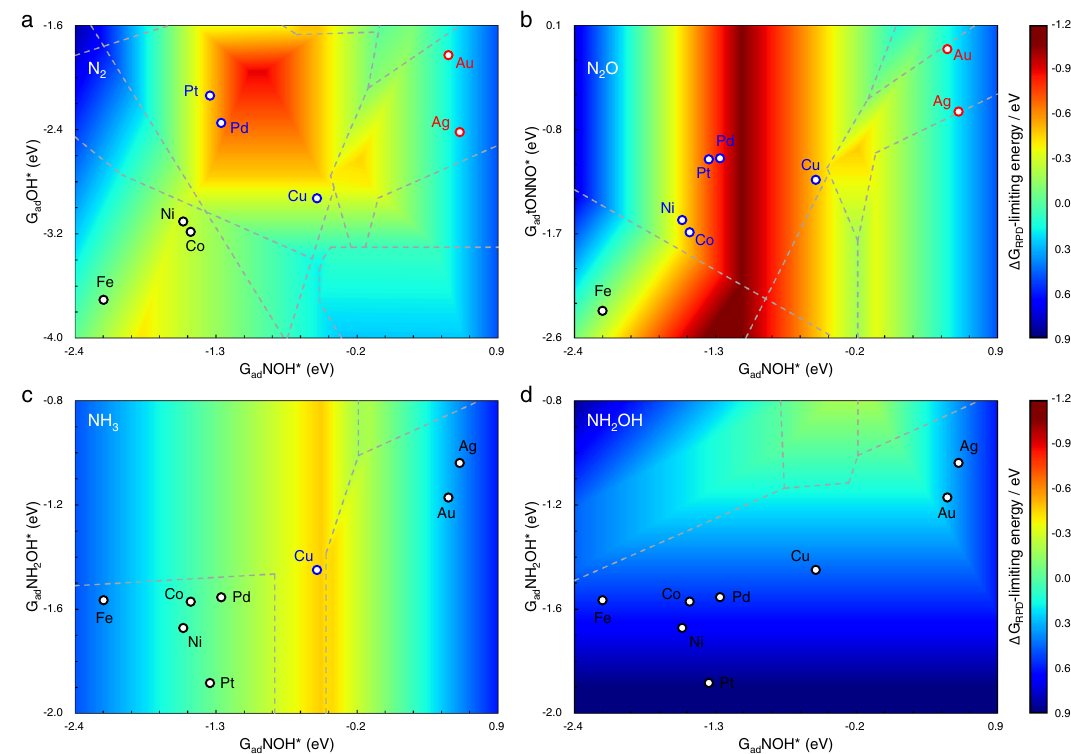
Supplementary Table 4). Δ G RPD -limiting energies are shown with reference to the color bar on the right.